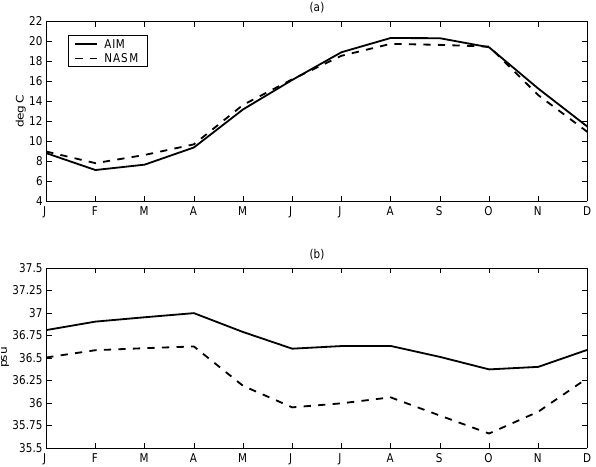
Fig. 14. Annual cycle of the basin averaged NASM temperature and salinity compared with the average computed over the AIM model domain sector corresponding to the NASM domain. Solid line: AIM, dashed line: NASM. (a) : Temperature; (b) : Salinity. Units are ◦ C for temperature and psu for